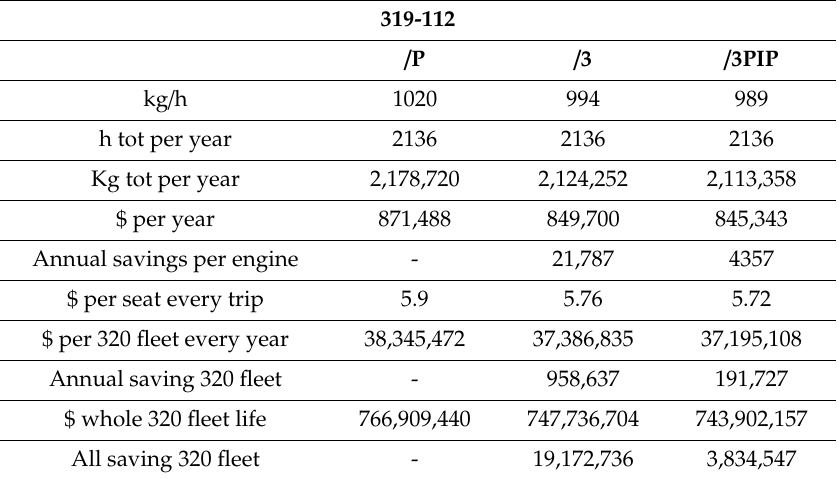
Table 5. Economic impact of upgrades in 319-112